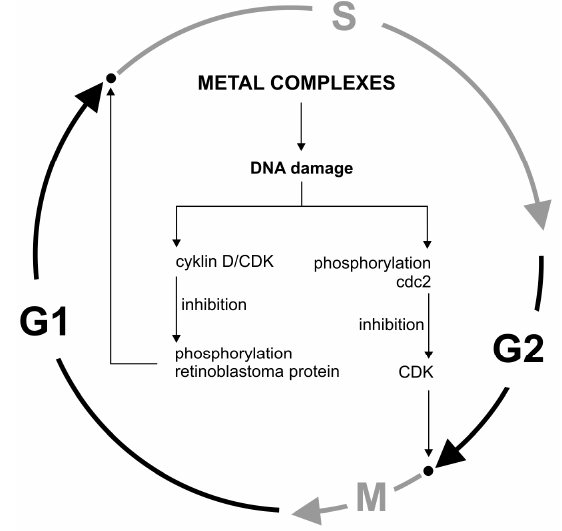
Figure 4. Cell cycle regulation by metals.